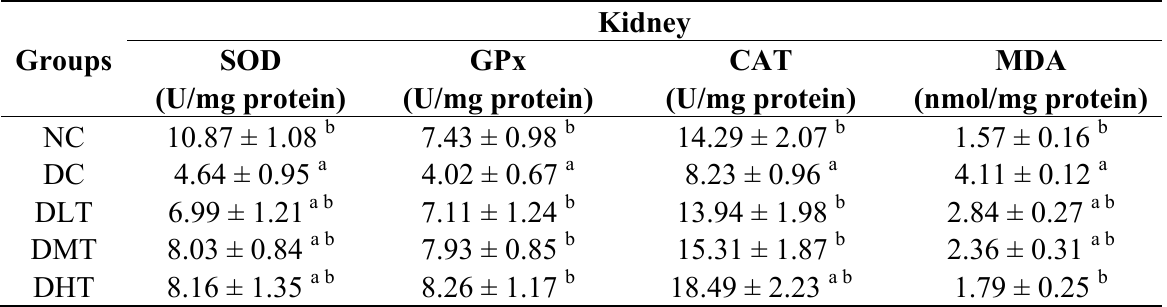
Table 2. Effect of salidroside administration on antioxidant enzymes activities and MDA levels in kidney in mice.